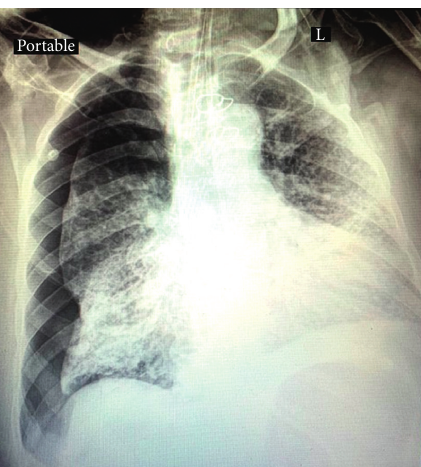
Figure 1: Pneumothorax with multiple scattered bilateral lung field air-pace opacities and diffuse ground-glass opacities.